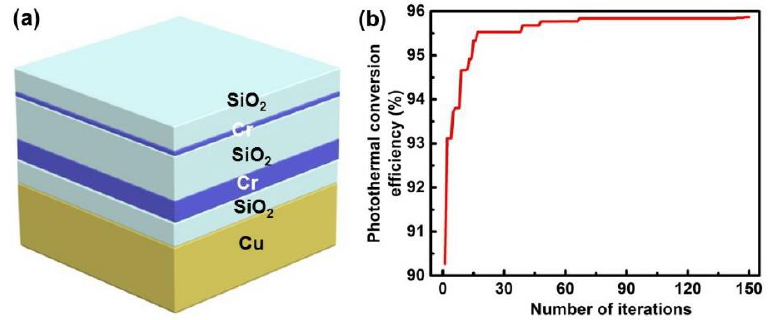
Figure 1. ( a ) Schematic six-layered SiO 2 / Cr film structure, ( b ) convergence curve of the six-layered SiO 2 / Cr film structure at the working condition of 600 K and 100 Suns.